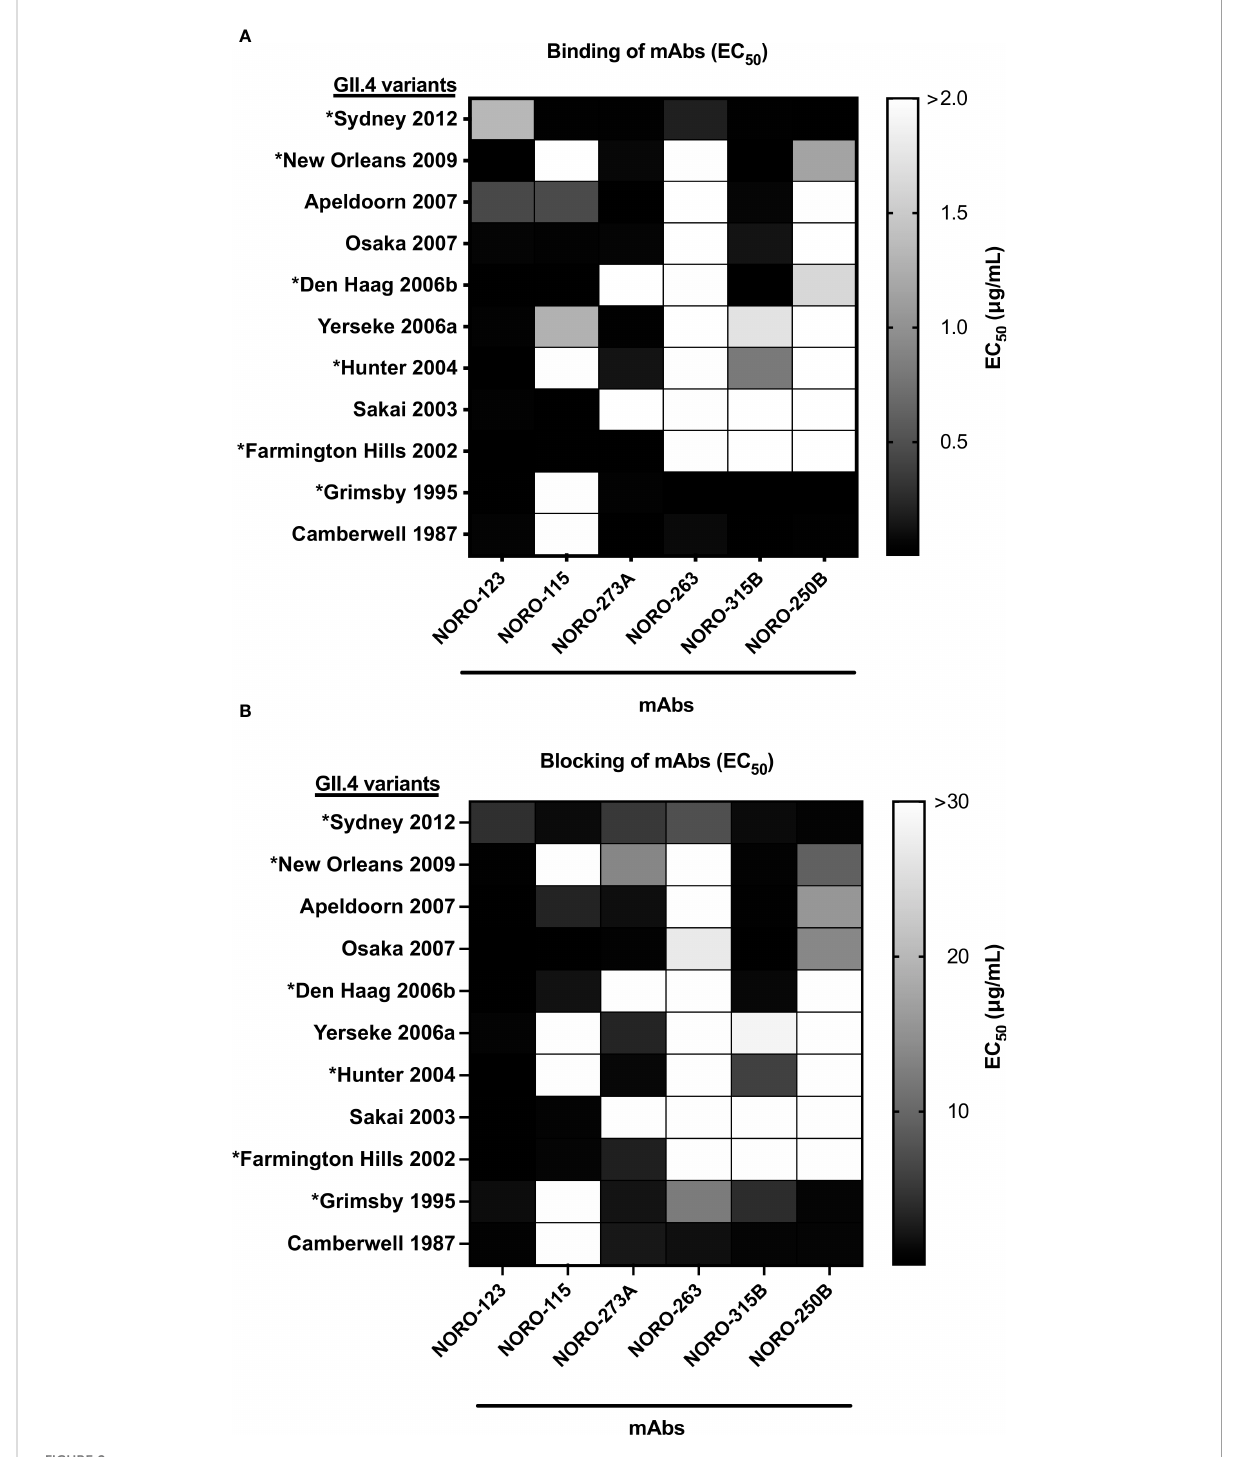
FIGURE 2 Human mAbs present varying binding and blocking pro fi les against multiple GII.4 variants spanning over three decades. (A) Heat map of the binding of mAbs to VLPs representing major and minor GII.4 variants. Each cell shows the average of the EC 50 values calculated as the half-maximal effective concentration that results in 50% binding to VLPs in duplicate wells, where 100% binding was set as the maximum average OD 405 nm value calculated from each plate at or near antibody saturation. Major pandemic variants are labeled with an asterisk. (B) Heat map of the carbohydrate blocking of human mAbs against VLPs representing major and minor GII.4 variants. Blocking of serial dilutions of mAbs was compared to the signal of the positive control, binding of VLPs in the absence of mAbs. Each cell shows the average of the EC 50 values calculated as the half- maximal effective concentration that results in 50% blocking of VLPs in duplicate wells. Major pandemic variants are labeled with an